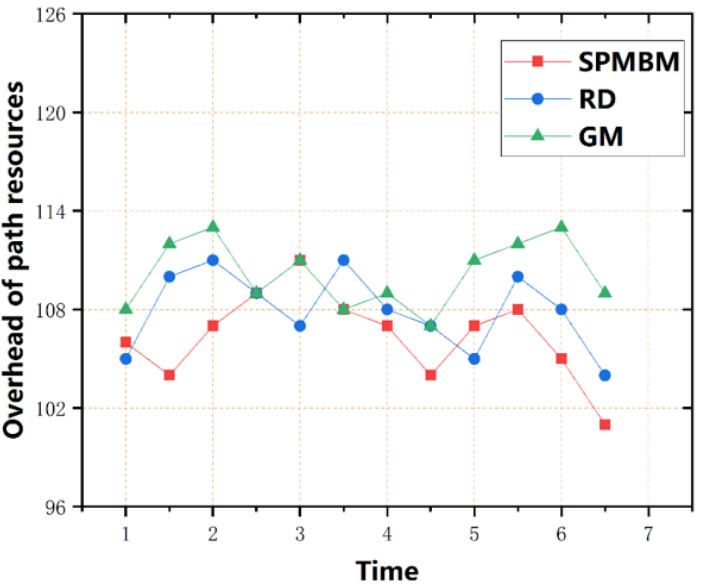
Figure 11. Relationship between overhead of path resources and time in three mobility models.